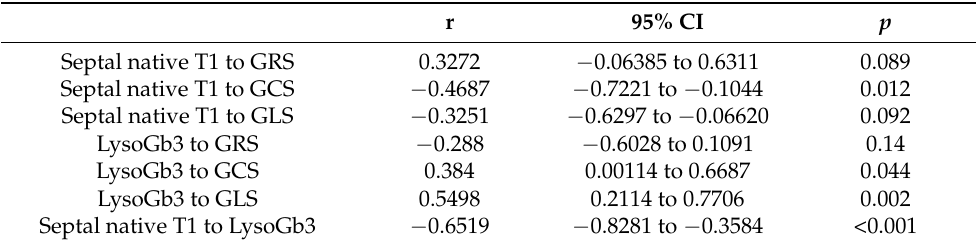
Table 3. Correlations of strain values, LysoGb3, myocardial mass and native